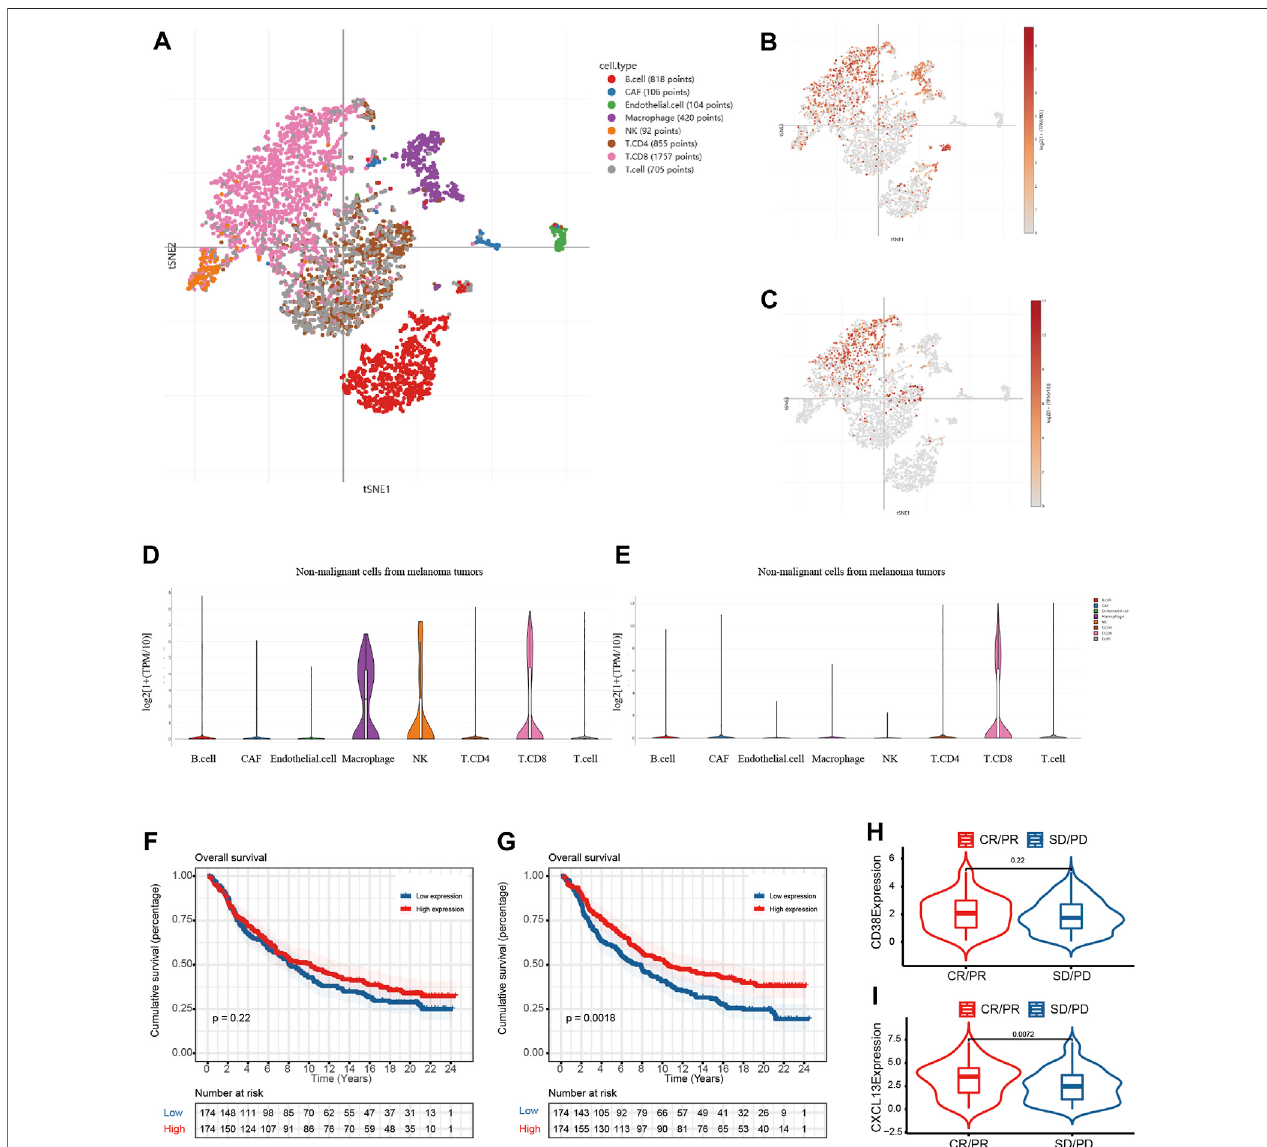
FIGURE7| ThepotentialprognosticvalueofCD38and CXCL13 inOCpatients withimmunotherapy. (A) tSNE plotofvarious celltypes intheGSE115978 cohort; (B,C) The expression of CD38 in multiple cells; (D,E) The expression of CXCL13 in multiple cells; Kaplan-Meier curves showed the prognosis of (F) CD38 and (G) CXCL13 in the IMvigor210 cohort; The violin plots showed the difference of (H) CD38 and (I) CXCL13 expression in the CR/PR and SD/PD groups. CR, complete response; PR, partial response; SD, stable disease; PD, progressive disease.